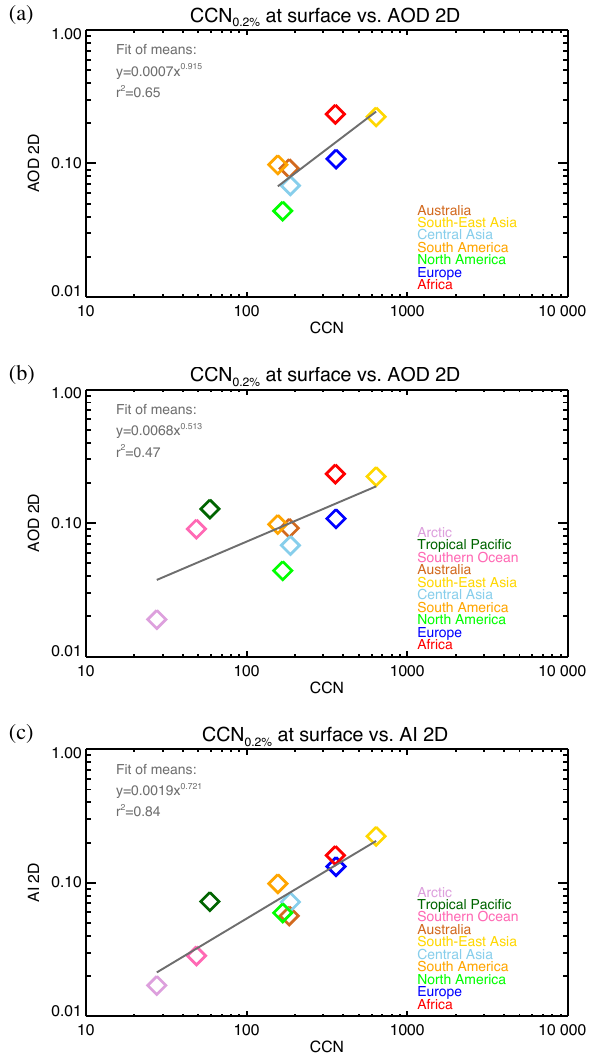
Figure 4. (a) Annual continental mean ECHAM-HAM simulated AOD [1] as function of CCN 0 . 2% (cm − 3 ) and their fit derived from linear regression (gray), (b) as (a) but including three ocean regions, (c) annual continental mean simulated AI as function of CCN 0 . 2% for continental and ocean regions as in (b) ; regional colour coding as in Fig. 3.